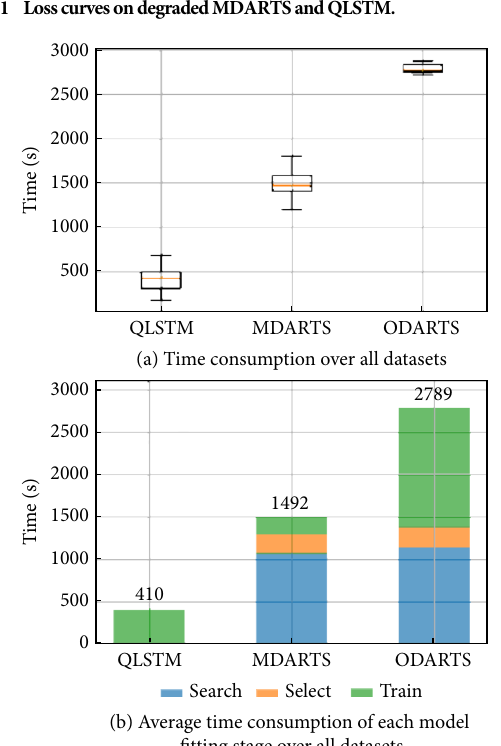
Fig. 12 Computation time